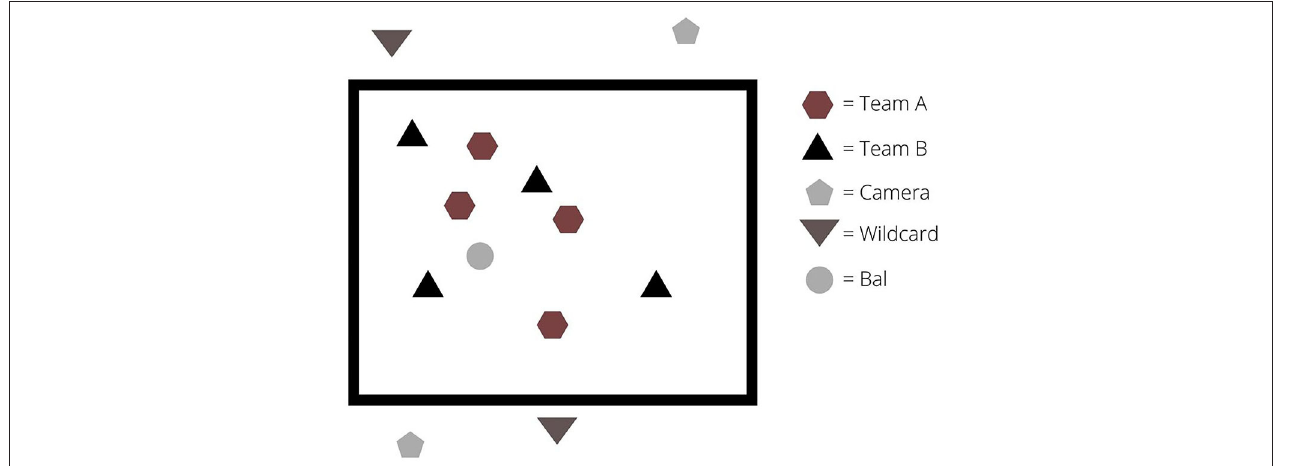
FIGURE A1 | A 4-vs.-4 position game played by peer-aged players with two wildcard players at the side. It was played on an 18.3 by 18.3-m field. Four games of 5 min each have been recorded by two cameras positioned on a wildcard’s side line.